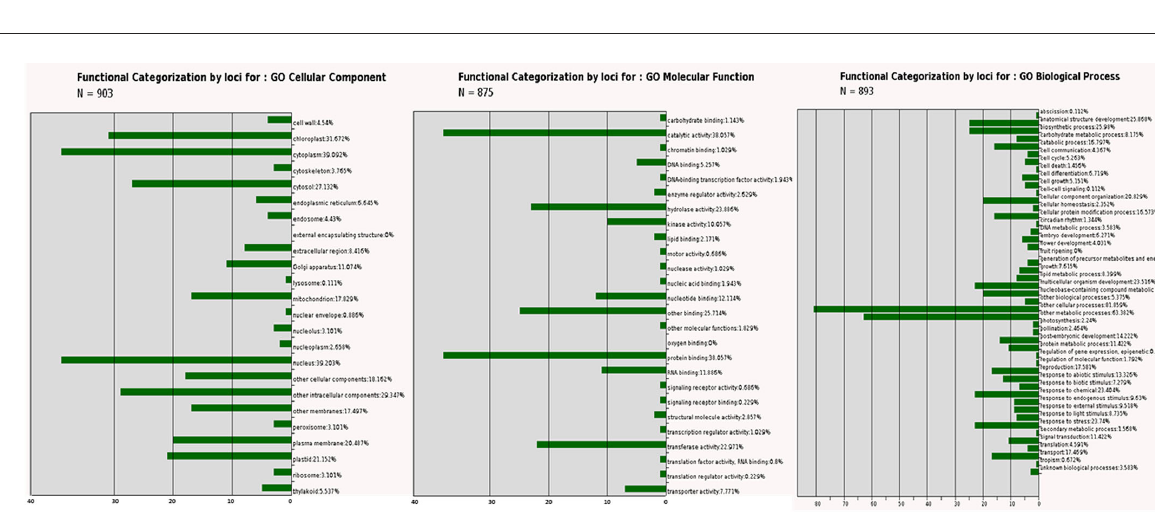
FIGURE7 Gene ontology-based functional categorization of 958 genes with unique PIP marker amplifications in Tunisia genome that are part of (i) cellular component, (ii) molecular function, and (iii) biological